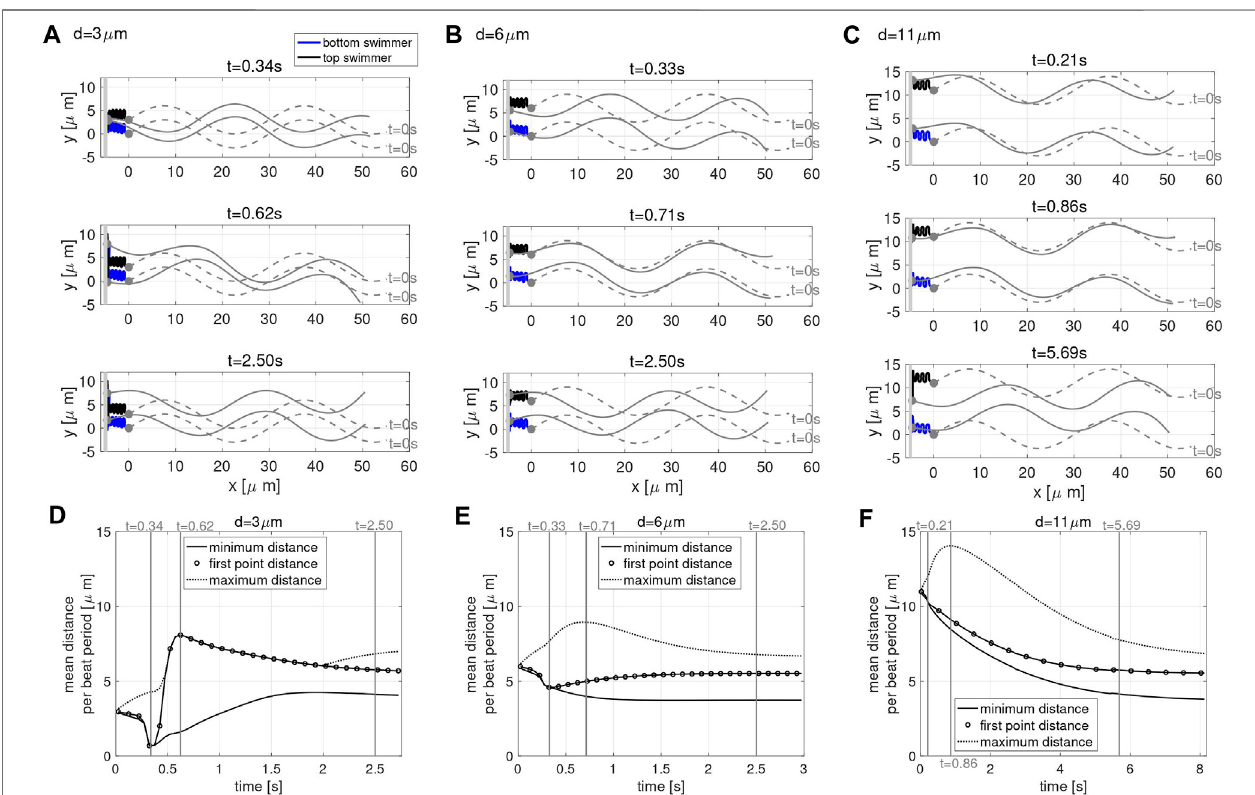
FIGURE 3 | Co-Planar Sperm Near a Wall. Swimmer con fi gurations with planar preferred beat forms at t (cid:1) 0 s (dashed gray lines) and at three snapshots in time (solidgraylines)fortheinitialdistance d (cid:1) 3 μ m (A) , d (cid:1) 6 μ m (B) and d (cid:1) 11 μ m (C) withaplanarwallat x (cid:1) − 5 μ m.Thetracesofthe fi rstpointontheswimmerareshown (blueand black solid lines). The time-dependent distance between swimmers ischaracterized in (D) – (F) . Forinitial swimmer distancesof d (cid:1) 3 μ m (D) , d (cid:1) 6 μ m (E) and d (cid:1) 11 μ m (F) , the minimum (solid line), maximum (dashed line), and fi rst point distance (circles) are reported as averages over each beat period. The times chosen toreporttheswimmercon fi gurationsforeachvalueof d (A – C) areidenti fi edwithverticalgraylinesinthecorrespondingdistancegraphs (D – F) .Thethickgrayverticalline in (A – C) represents the wall.